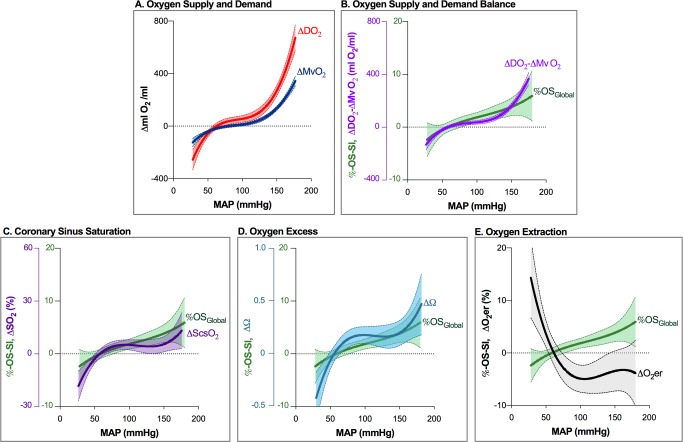
Non-linear response of descriptors of myocardial oxygenation balance to pharmacologically induced blood pressure changes.A. Response of oxygen delivery (ΔDO2, red, n = 88) and myocardial oxygen consumption (ΔMVO2, dark blue, n = 74) relative to their baseline (arbitrarily set at a MAP of 70mmHg). Both, ΔDO2 and ΔMVO2 reveal an autoregulatory plateau and steep slopes beyond autoregulatory limits. Within the autoregulation zone, DO2 consistently surpasses MVO2, whereas there is mismatch between DO2 and MVO2 outside autoregulatory limits. At hypotension, ΔMVO2 is no more matched by ΔDO2, while there is redundant oxygen supply at hypertensive MAP beyond 130 mmHg. B. Curvilinear response to MAP variation of arterio-venous difference (ΔDO2 - ΔMVO2; purple n = 74) and myocardial oxygenation response (%OS-SI; green, n = 94). Note upslope beyond autoregulatory limits. C. Curvilinear response to MAP of coronary sinus oxygen saturation (ScsO2, purple, n = 75) and D. oxygen excess Ω (blue, n = 75). E. MAP-associated OS-SI rise is accompanied by falling coronary blood oxygen extraction ratio (O2eER, black, n = 75), due to improving DO2. x-axis intercept of fitted curves is at a MAP of 50-60mmHg. This indicates the lower limit of autoregulation and is consistent with calculated limits (see S1 File). Line: fitted mean of non-linear regression; shaded area: 95% confidence interval.